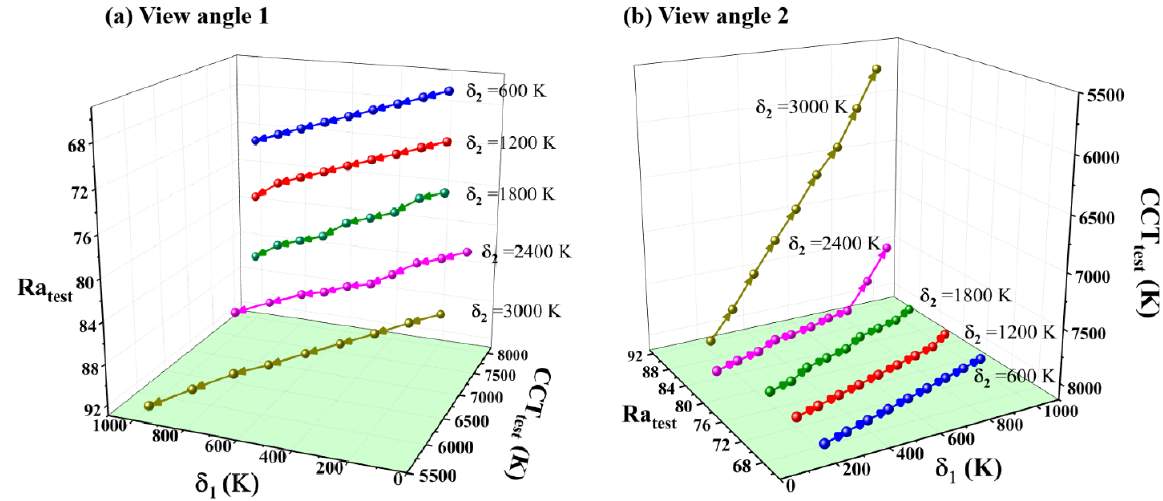
Figure 3. Shifting trend of CCT test , Ra test , and δ 1 under different δ 2 in a 3D coordinate diagram with CCT tar of 8000 K. ( a , b ) are the same 3D figure at different view angles.